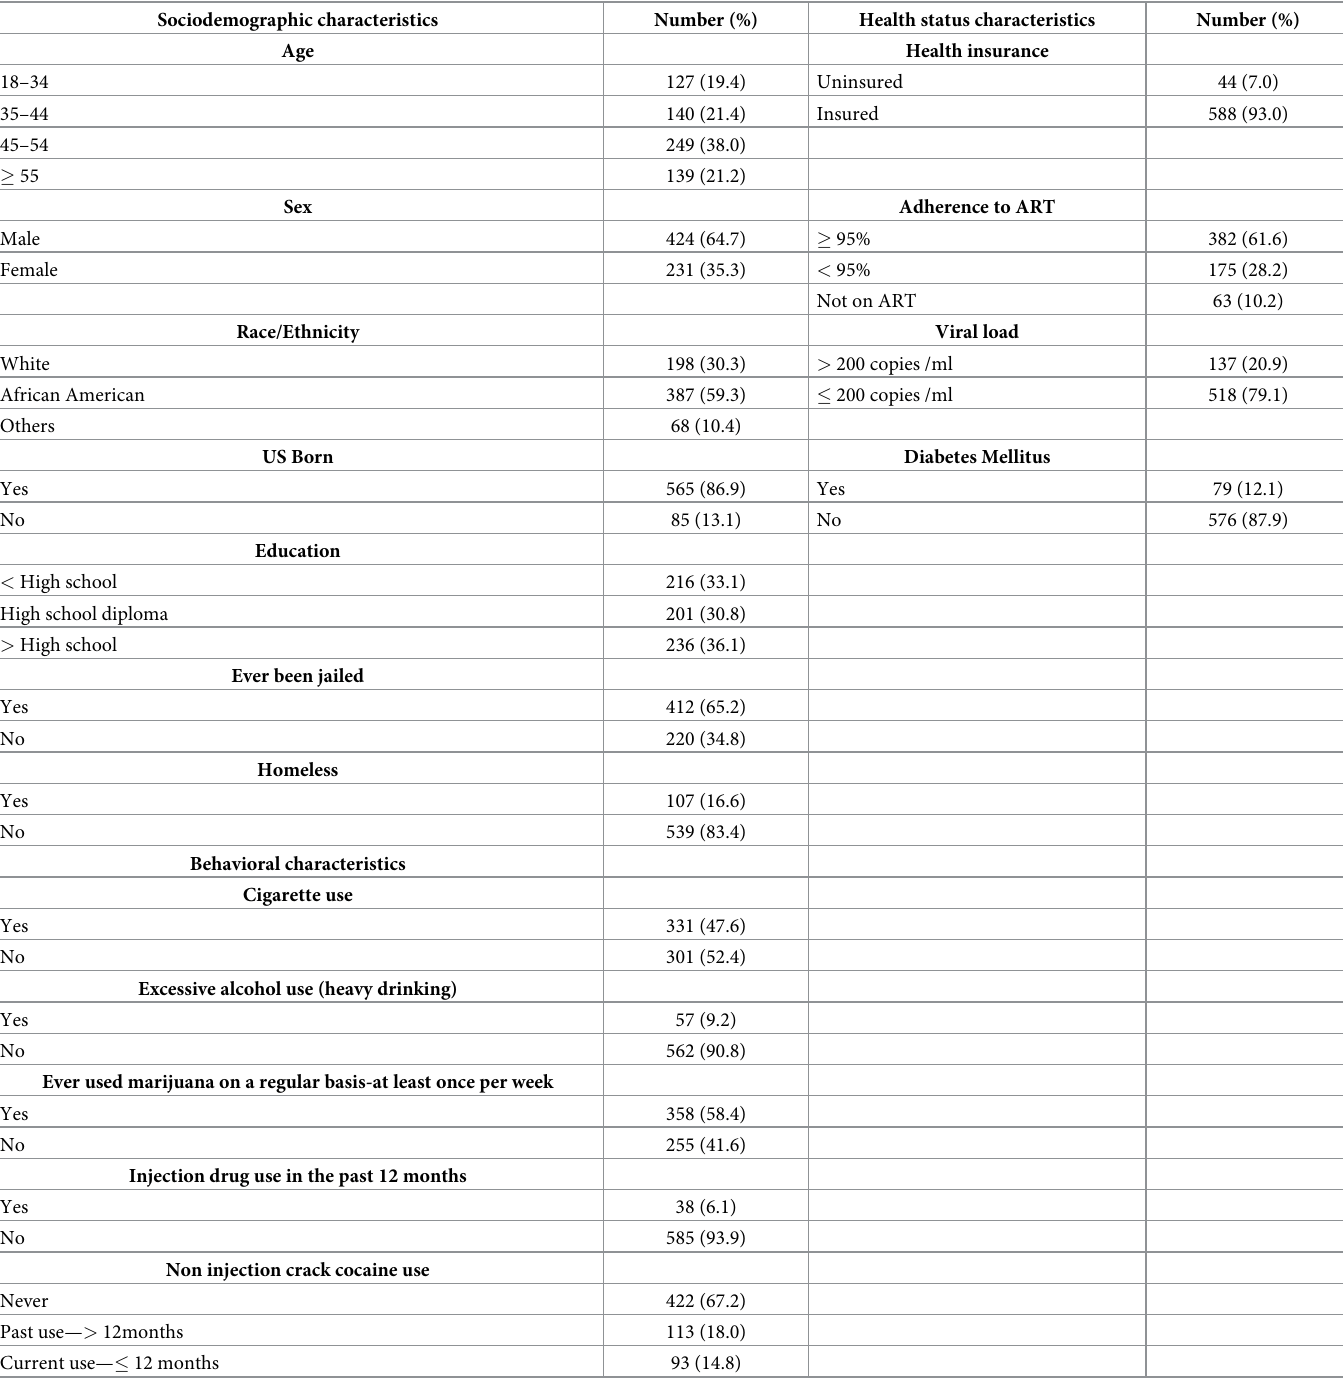
Table 1. Baseline characteristics of 655 persons living with HIV in the Florida Cohort who had medical records,